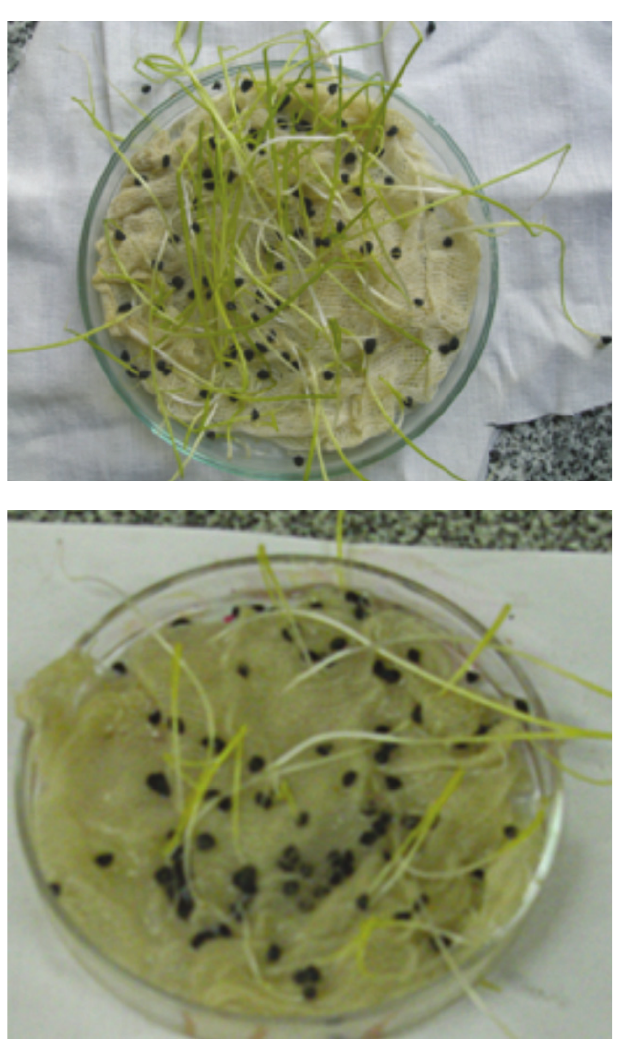
Fig. 1: Effect of controlled atmosphere (8% CO germination percentage of onion seeds (lift, seeds treated with controlled atmosphere and right is untreated seeds or control, photo by K. Abd El- Gawad)